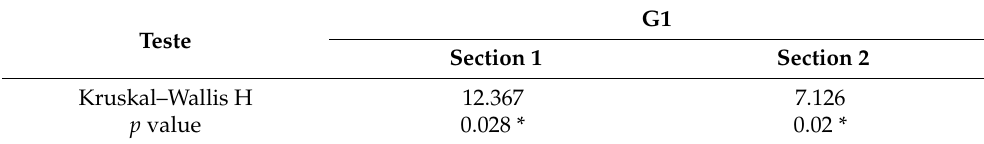
Table 3. Kruskal–Wallis test results.